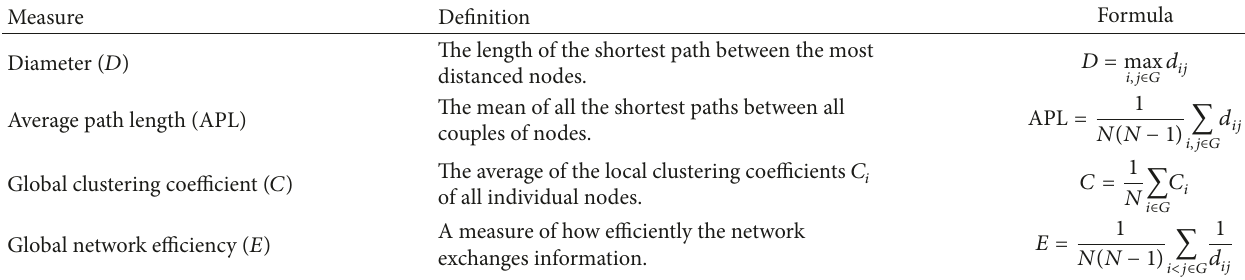
Figure 1: Process of link addition/removal of the subgraph made up of the highest degree nodes in order to reach different density values.